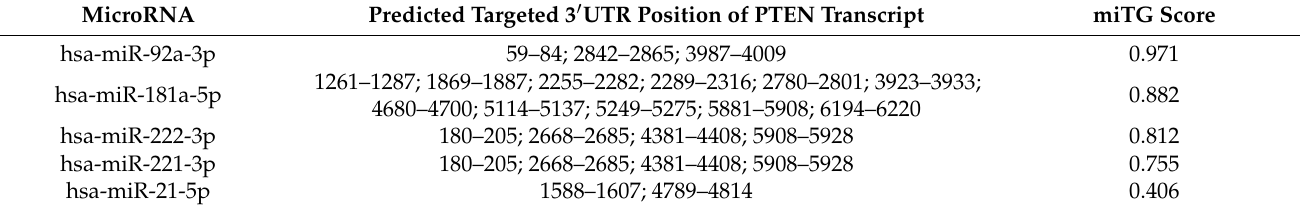
Table 2. PTEN target prediction scores of identified miRs. DIANA TOOLS miTG prediction score of the probability that the identified miRs will target PTEN. The closer the miTG score is to 1.0, the higher the probability of targeting.